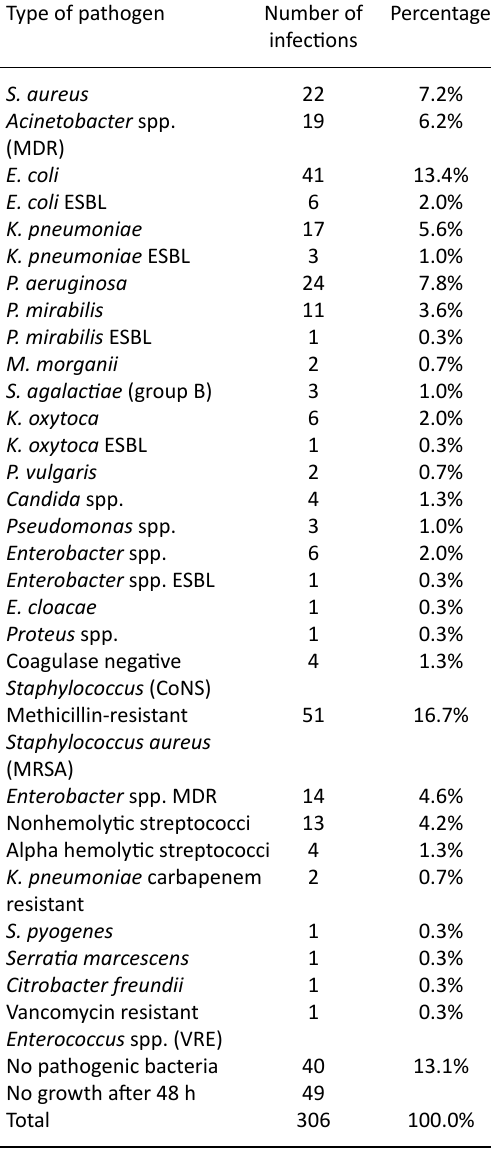
Table 4-A.1. Bacterial profile and patterns of infection for wound